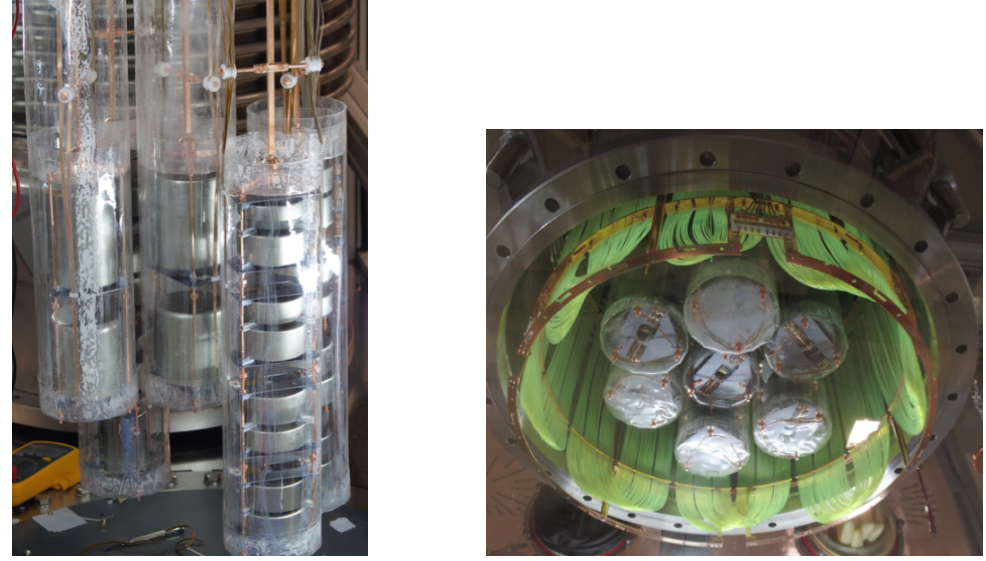
Figure 2. The Phase II Ge array with the individual Ge detector strings inserted in TPB coated nylon mini-shrouds ( left ) and the Fiber Shroud surrounding the detector strings once lifted up in the lock ( right